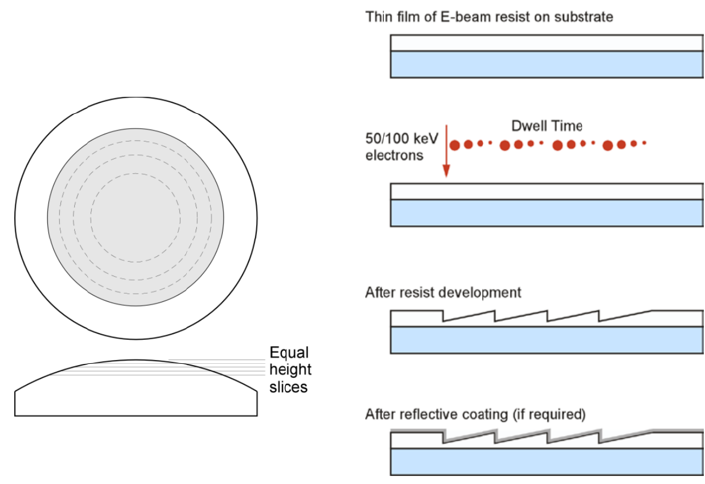
Figure 5. Flow of grating preparation by electron beam lithography [40].